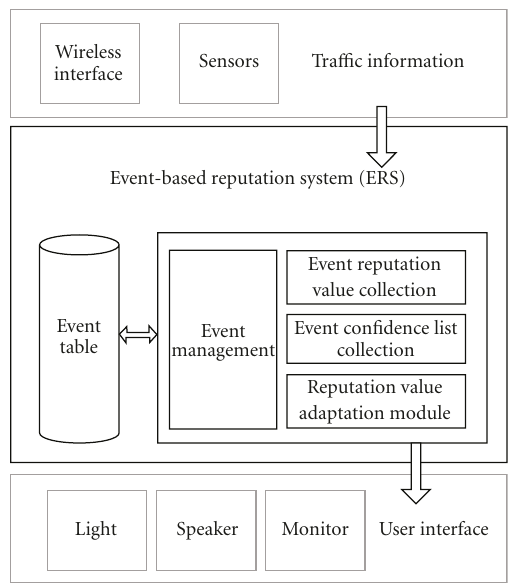
Figure 1: System architecture of the proposed event-based reputa- tion